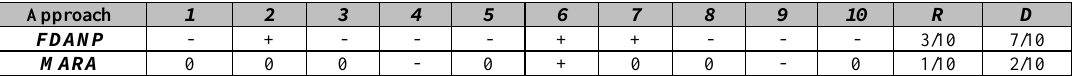
Table 4. Robustness and Debility of O 1 under MARA and the proposed